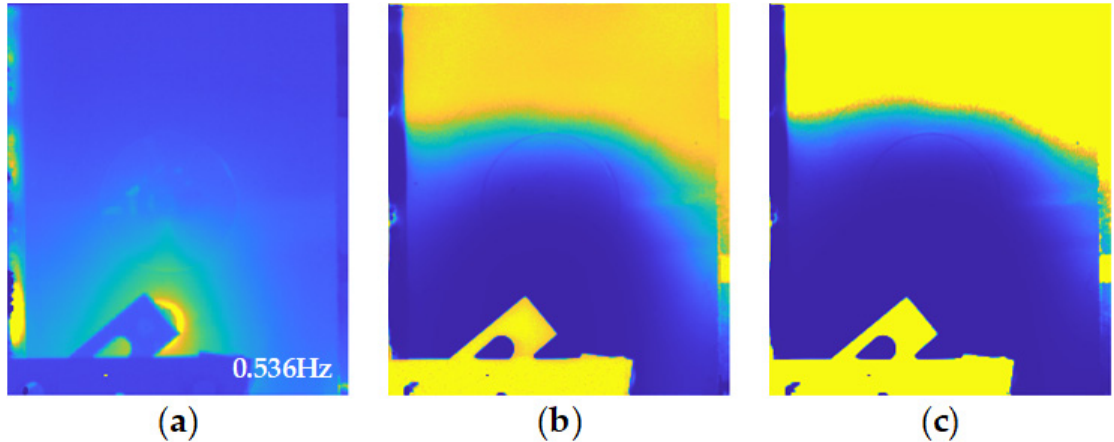
Figure 13. Features extracted from the VT experiment on Al_B_60J sample: ( a ) amplitude imaging feature; ( b ) skewness feature; ( c ) kurtosis feature.